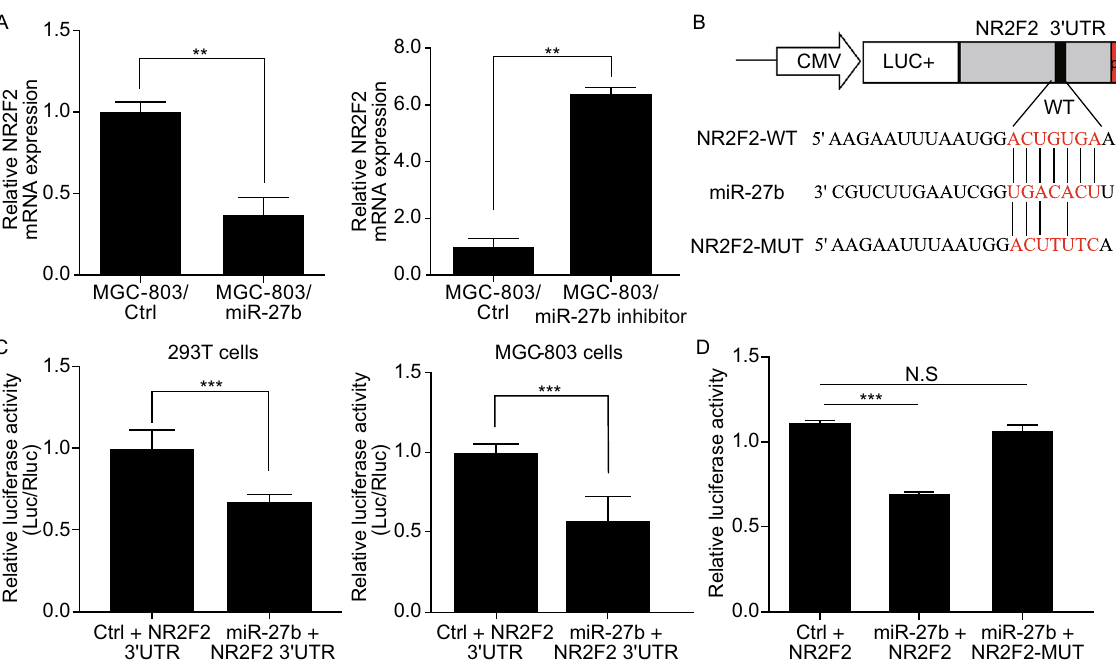
Figure 6. NR2F2 are direct targets of miR-27b. (A) The mRNA levels of NR2F2 in MGC-803/miR-27b and MGC-803/ctrl cells were analyzed by real-time PCR. The mRNA levels of NR2F2 in GES-1/miR-27b inhibitor and GES-1/ctrl cells were further analyzed by real-time PCR. (B) Constructed luciferase reporter vectors containing wild-type or mutant 3 ′ UTRs of NR2F2. (C) The effects of miR- 27b overexpression on the activity of the 3 ′ UTRs of target genes in 293T cells and MGC-803 cells were analyzed by the dual luciferase reporter assay. (D) The effects of miR-27b expression on the activity of wild-type and mutant 3 ′ UTRs of NR2F2 were analyzed by the dual luciferase reporter assay. N.S.: no signi fi cance, * P < 0.05, ** P < 0.01, *** P